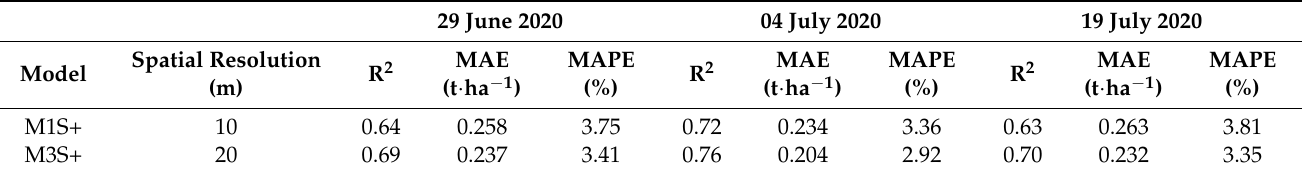
Table 4. JSendra best model evaluation for each date and spatial resolution with training data.